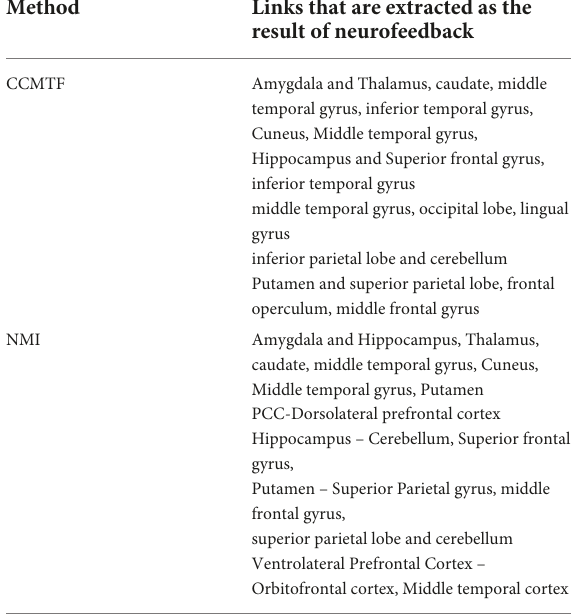
TABLE 4 The extracted links as the result of neurofeedback, by CCMTF and NMI methods.